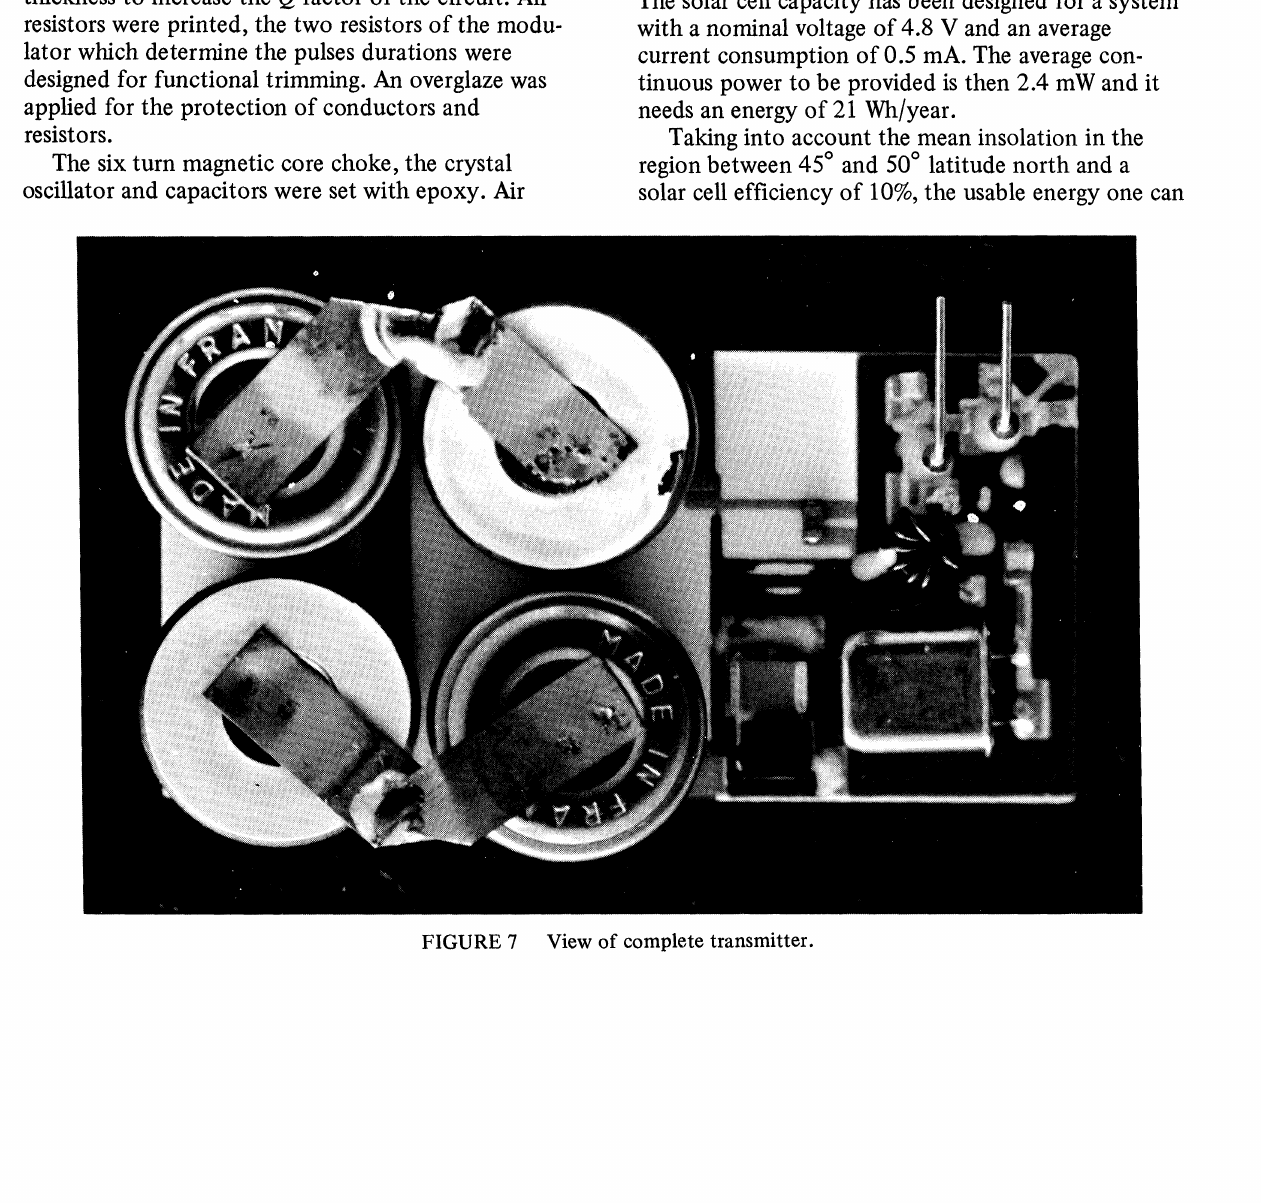
FIGURE 6 Circuit diagram of battery system.